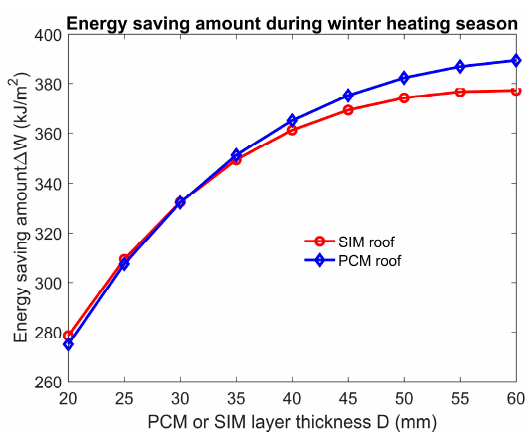
Figure 11. The effect of layer thickness on the energy saving amount of PCM or SIM roofs during the winter heating season.